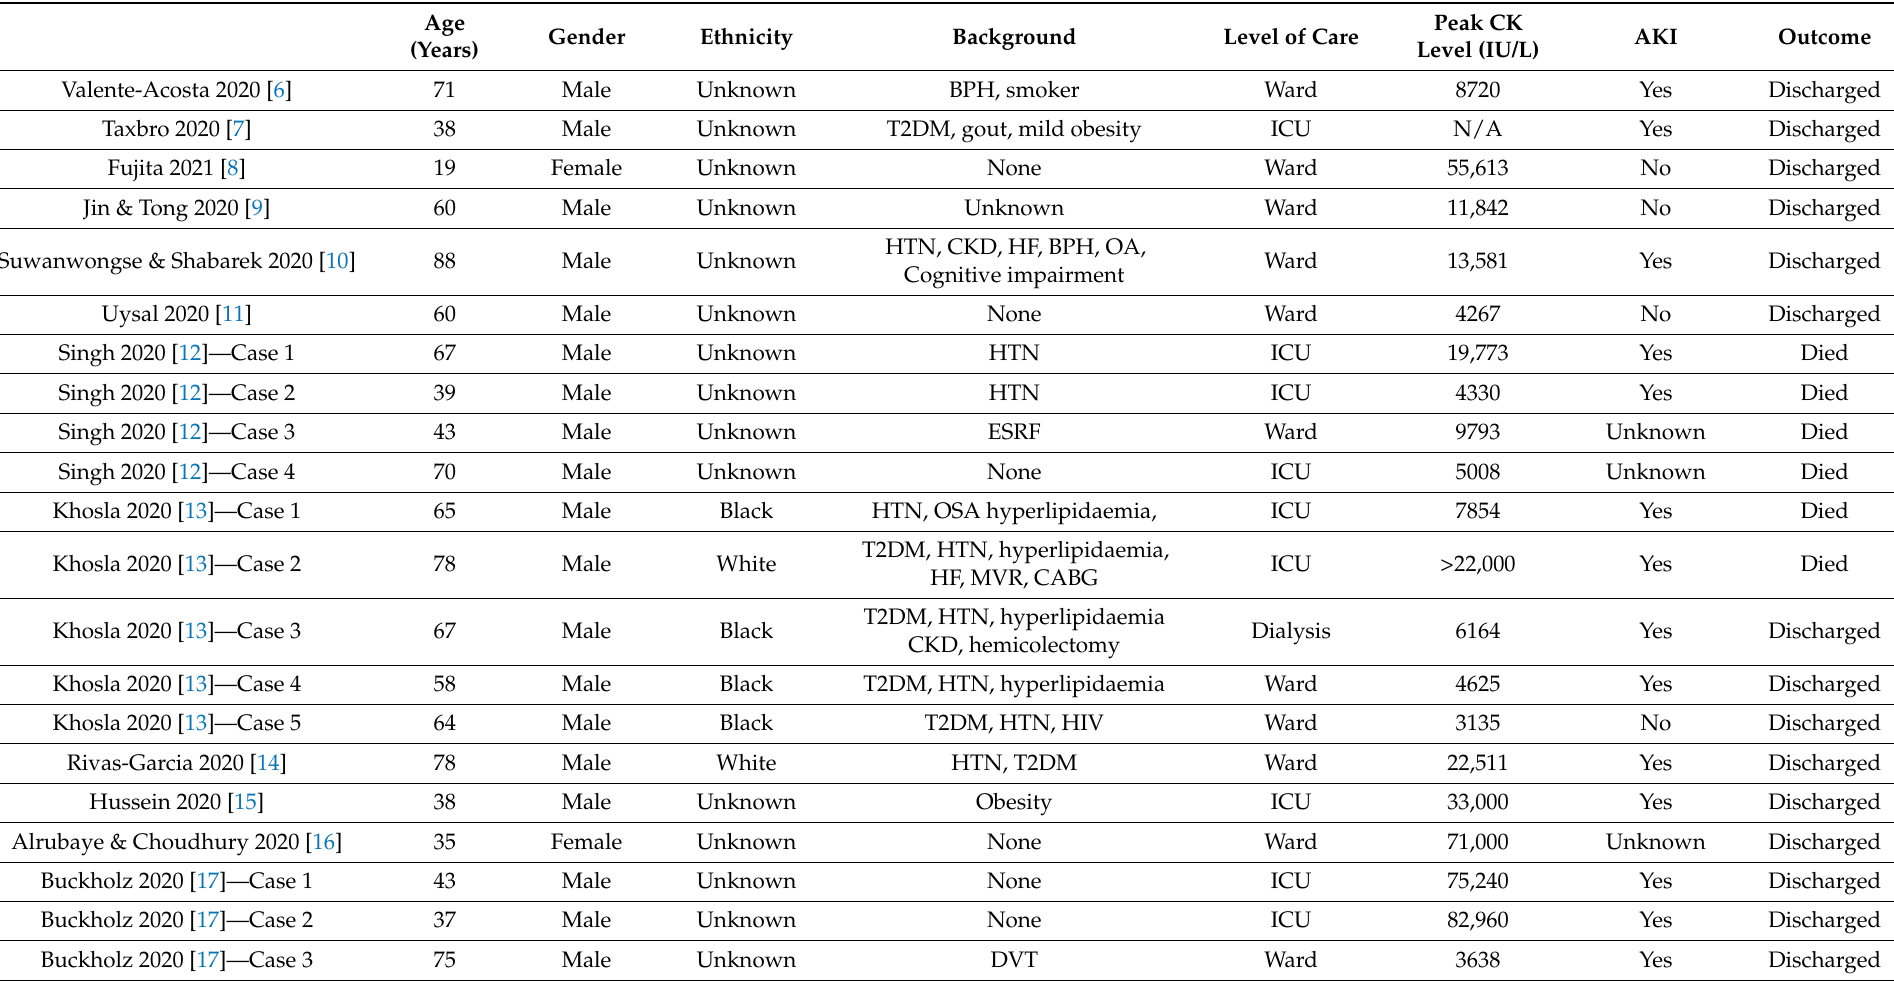
Table 2. Summary of case reports in the literature describing rhabdomyolysis in